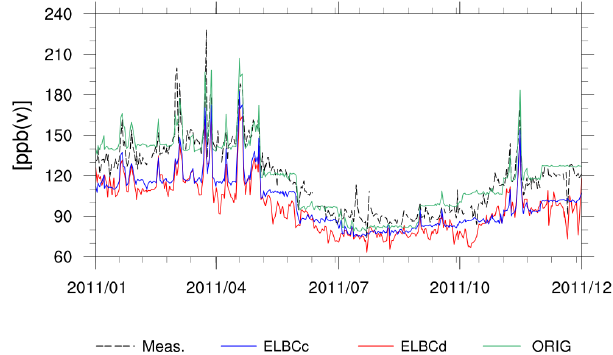
Figure 10. Time series showing the summer season of 2011 for CO, at the Mace Head station.